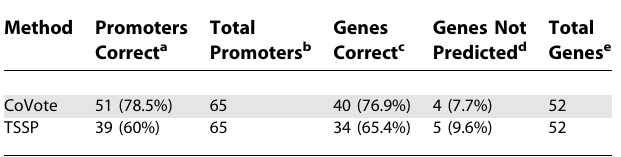
Table 7. The Results of Promoter Prediction by CoVote and TSSP on A. thaliana MicroRNA Genes Whose Promoters Were Identified by Xie et al.